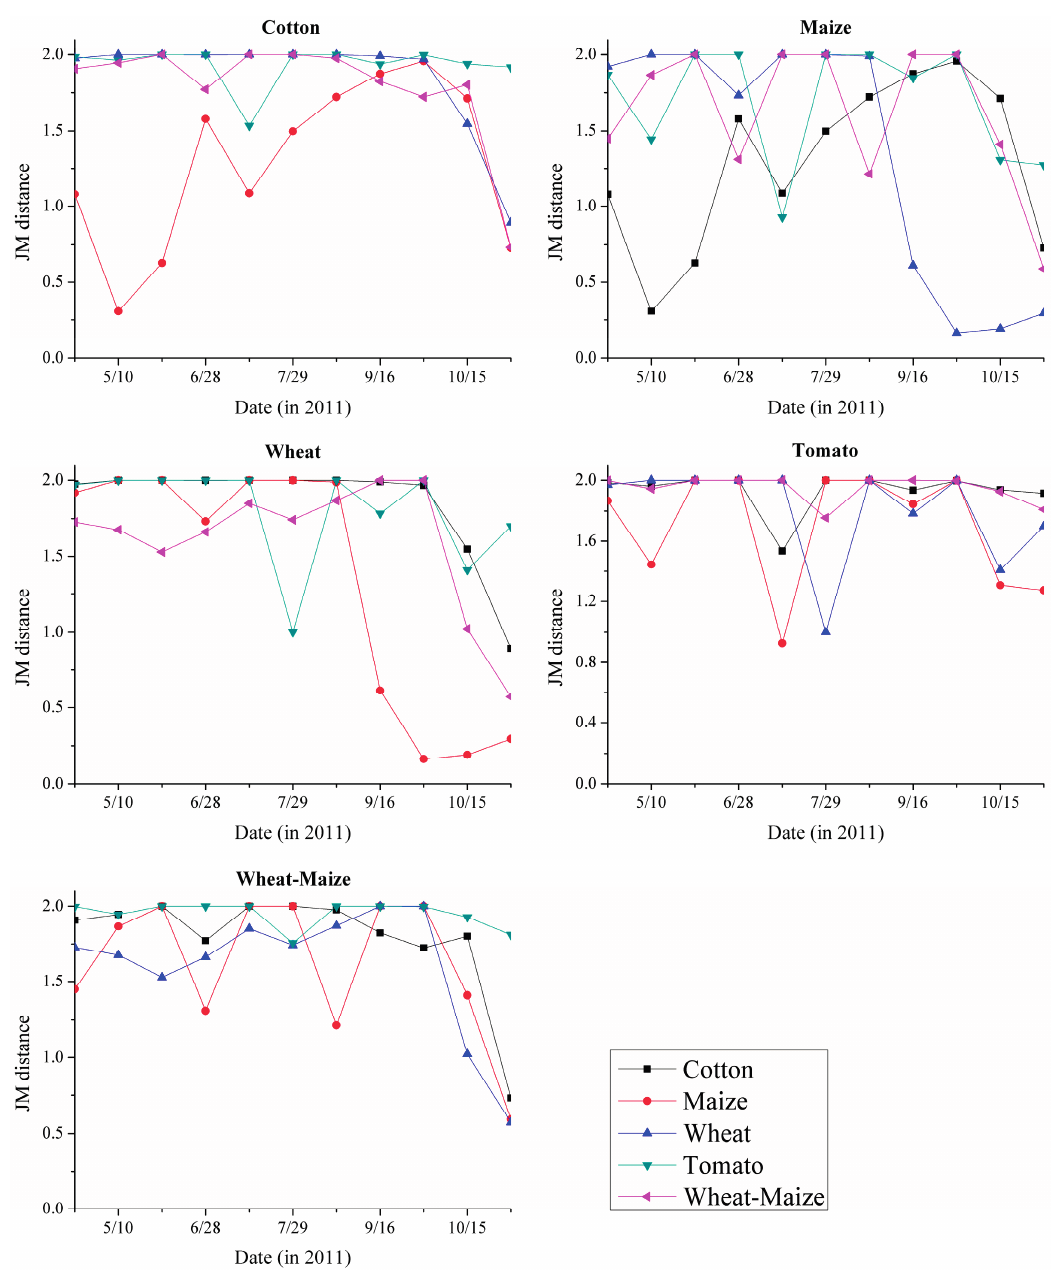
Figure 7. JM distances values for all pair-wise crop comparisons for the entire time series using training samples from